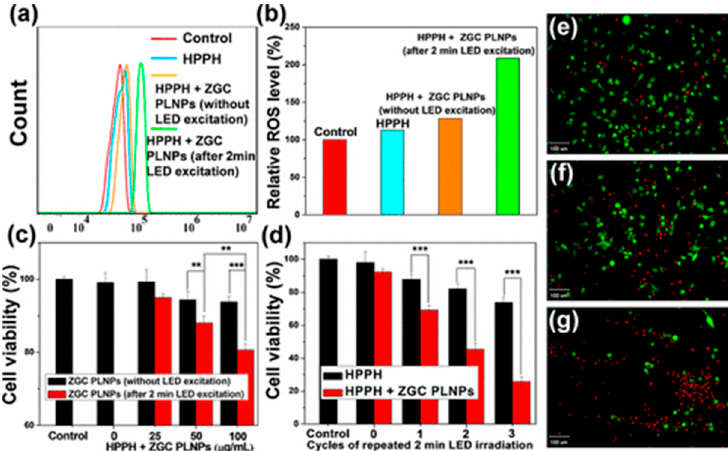
Figure 19. ( a ) HeLa cell viability without light excitation (blue bar) and after 2 min of irradiation (red bar). Luminescence imaging of HeLa cells treated with ( b ) PBS, ( c ) PBS + X ‐ ray, ( d ) 150 μ g mL − 1 ZnGa 2 O 4 :0.5% Cr III , 0.5%W VI + X ‐ ray, ( e ) 5 μ g mL − 1 ZnPcS4 + X ‐ ray, ( f ) 5 μ g mL − 1 ZnPcS4 + LED, and ( g ) 5 μ g mL − 1 ZnGa 2 O 4 :0.5% Cr III , 0.5%W VI –ZnPcS4 + X ‐ ray. LED ( λ exc = 670 nm, P = 160 mW cm − 2 ). ( h ) HeLa cell viability without (pink bar) and after 2 min of X ‐ ray irradiation (dark blue bar). The cells were treated with 150 μ g mL − 1 ZnGa 2 O 4 :0.5% Cr III , 0.5%W VI + X ‐ ray, 5 μ g mL − 1 ZnPcS4 + X ‐ ray, 5 μ g mL − 1 ZnPcS4 + LED, and 5 μ g mL − 1 ZnGa 2 O 4 :0.5% Cr III , 0.5%W VI – ZnPcS4 + X ‐ ray. In the luminescence images, Calcein AM (green fluorescence) and propidium iodide (red fluorescence) indicates the living and dead cells, respectively. Reproduced from [282] with permission from Wiley.